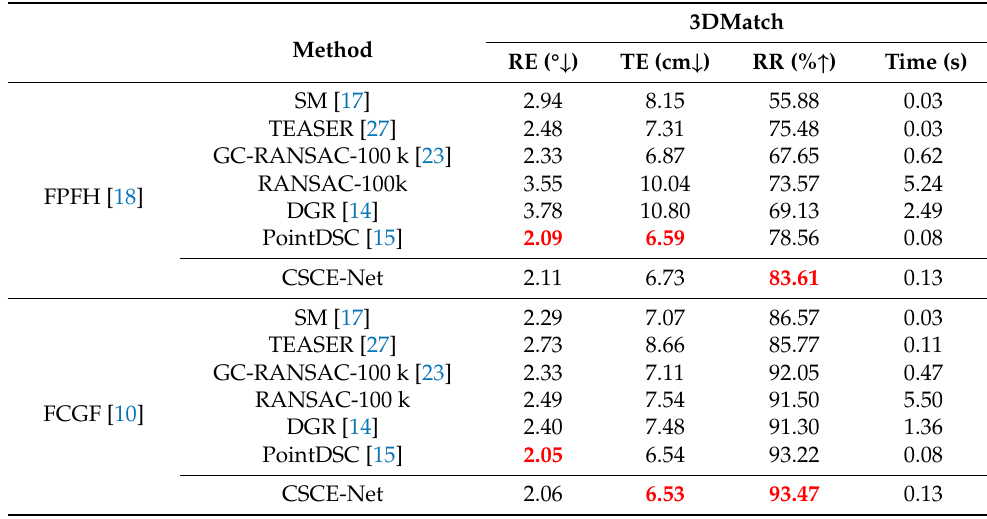
Table 2. Quantitative results of pose estimation on the 3DMatch